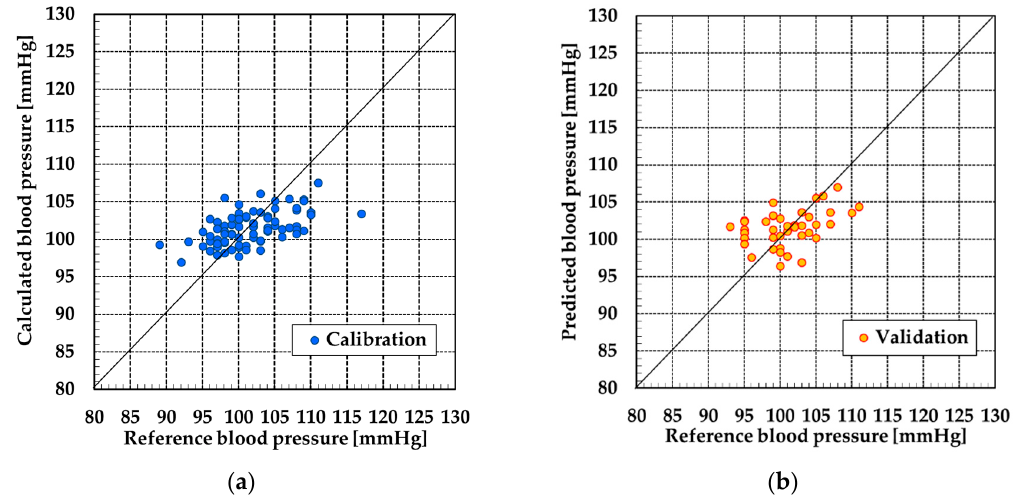
Figure 11. Result at SBP by PLSR of subject B: ( a ) calibration and ( b ) validation.